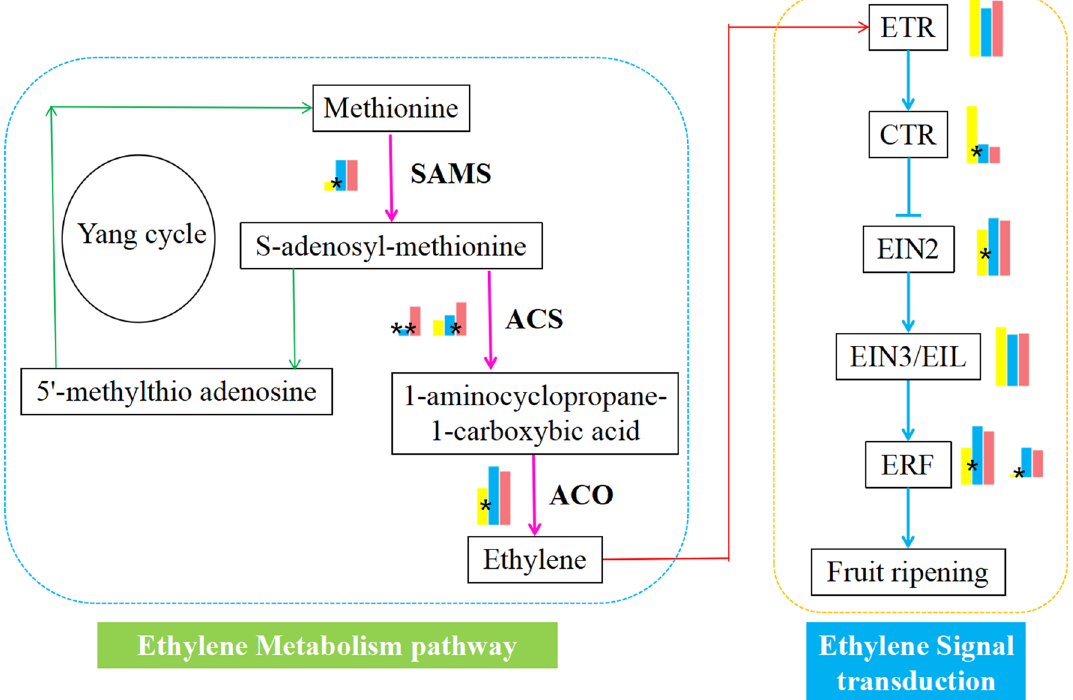
Figure 7. Ethylene metabolism and ethylene signal transduction pathways. Note: Green right arrow Yang cycle, Pink right arrow Ethylene metabolism, Blue right arrow Ethylene signal transduction, blue lined vertical negative regulation, blue dotted line Ethylene metabolism, yellow dotted line Ethylene signal transduction, yellow square the FPKM of S3, blue square the FPKM of S4, pink square the FPKM of